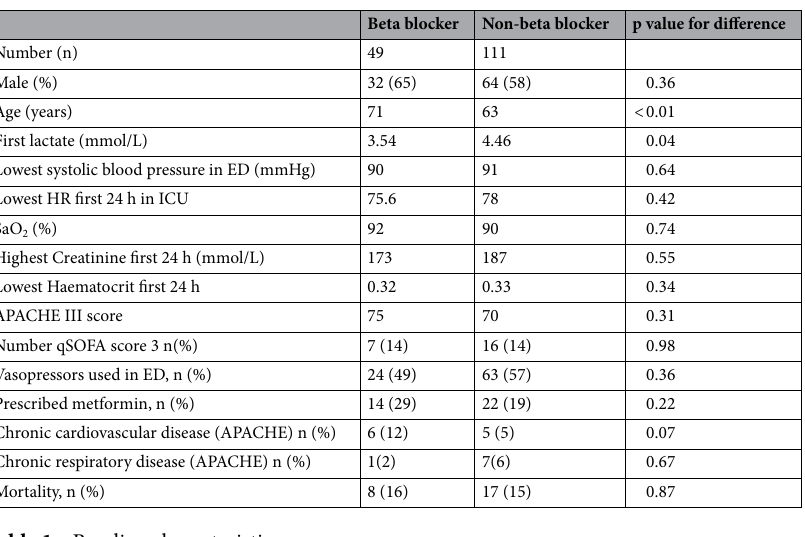
Table 1. Baseline